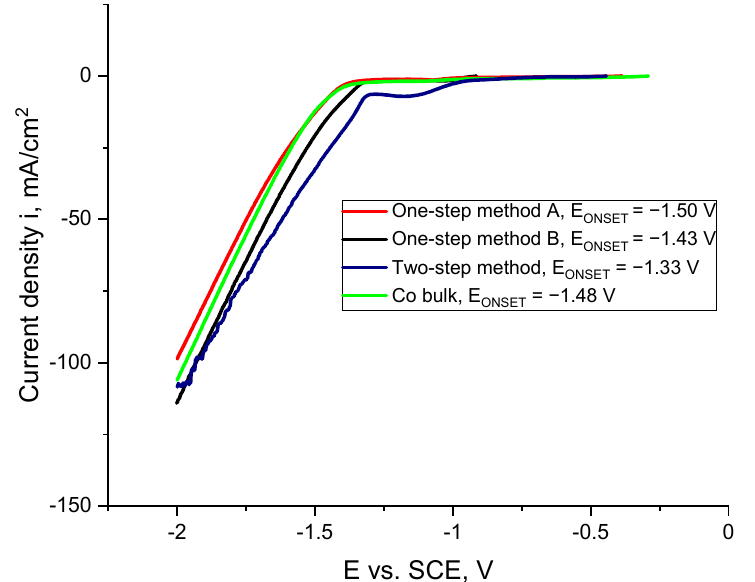
Figure 10. LSV curves of Co bulk and Co cones obtained using one-step in different conditions and two-step method in 1 M NaOH solution.